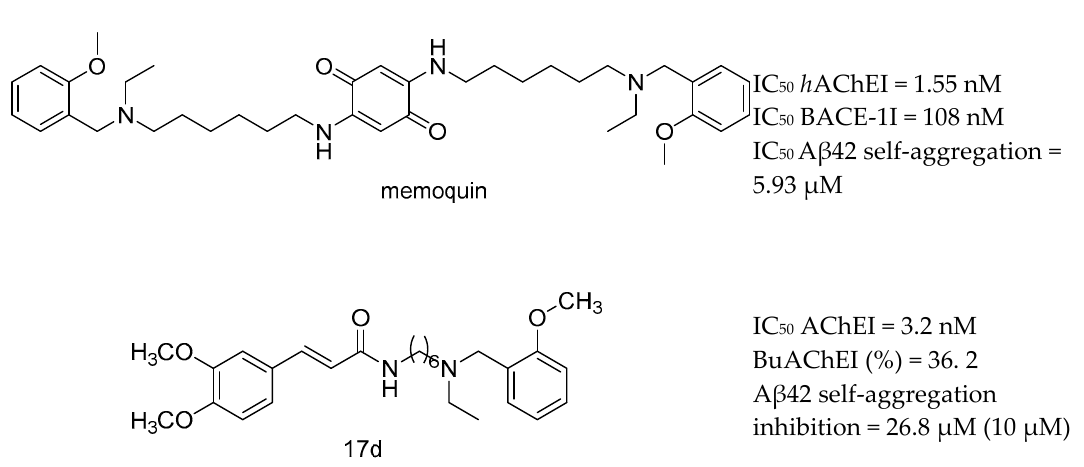
Figure 3. Memoquin and 17d, the most active ferulic acid-memoquin hybrid, from [97].